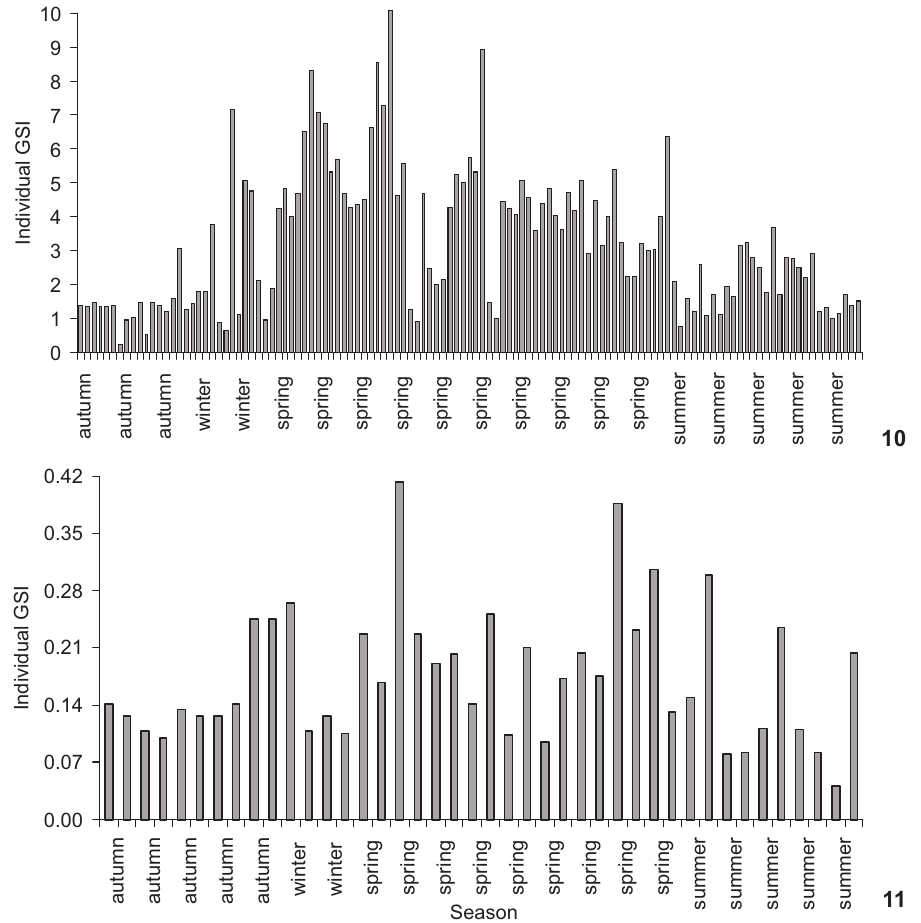
Figures 10-11. Seasonal distribution of the individual GSI values for females (10) and males (11) of A. lineatus in the Paranaguá Bay, state of